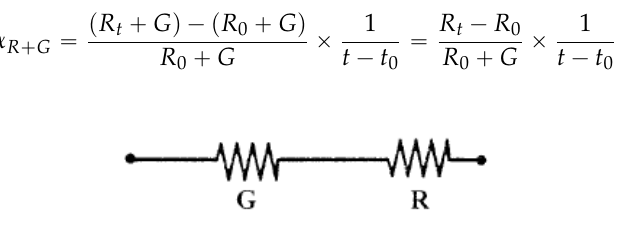
Figure 2. Serial connection for compensation of the bridge offset output voltage.